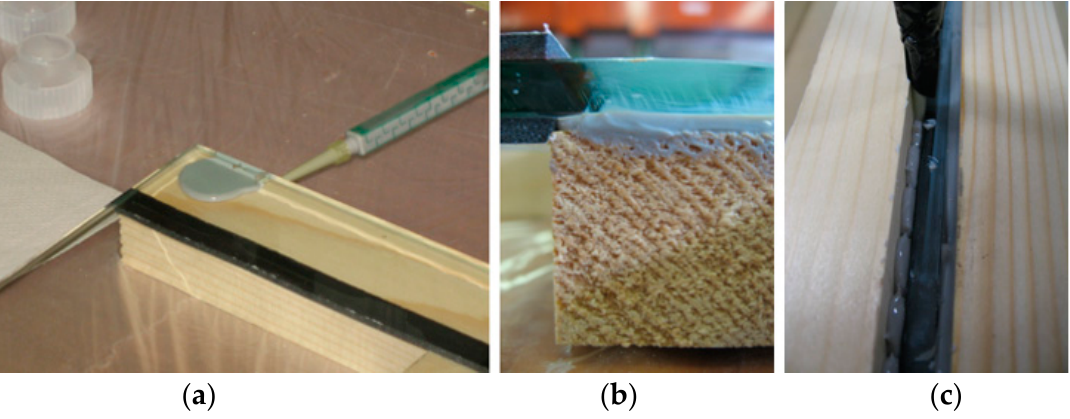
Figure 11. ( a ) application of the acrylate between the glass and the timber; ( b ) the appearance after the first bonding; ( c ) the application of the adhesive between the second flanges and the glass web. The application thickness is limited to a minimum of 0.5 mm and a maximum of 3